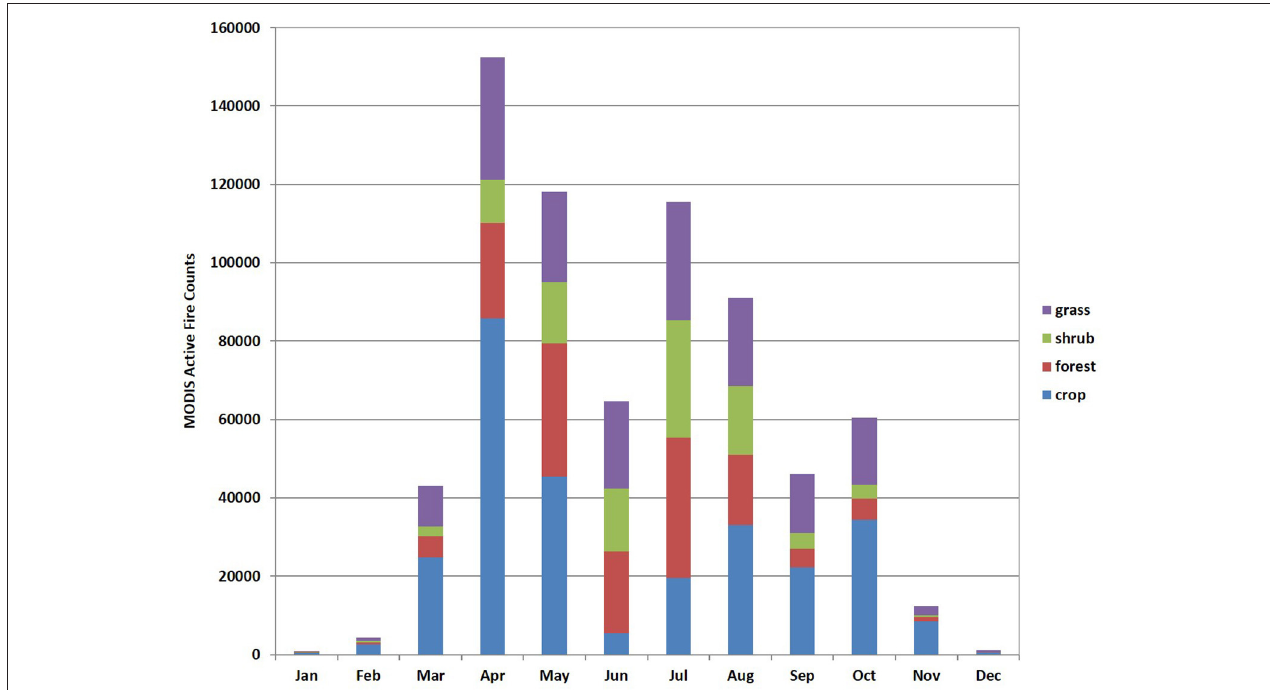
FIGURE 1 | Average monthly MODIS active fire counts (2003–2015) within Russian grasslands, shrublands, forest and croplands as defined by the International Geosphere-Biosphere Programme (IGBP) land cover type data layer (MCD12Q1; Friedl et al.,